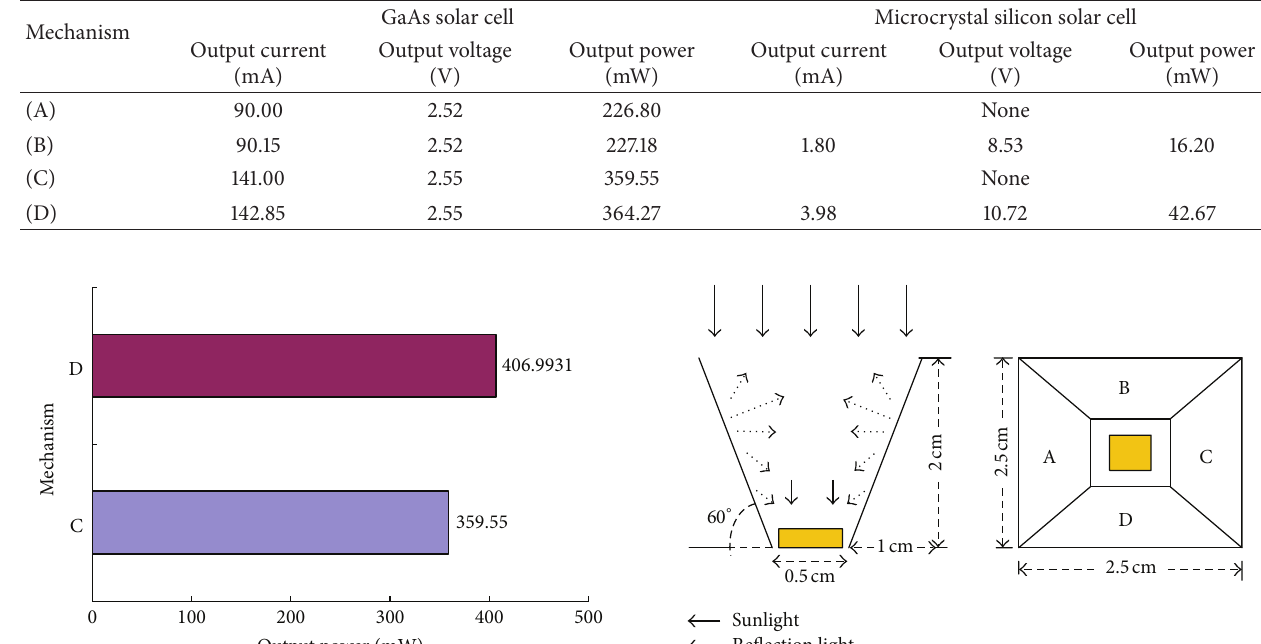
Table 2: The output property of the four different mechanisms.